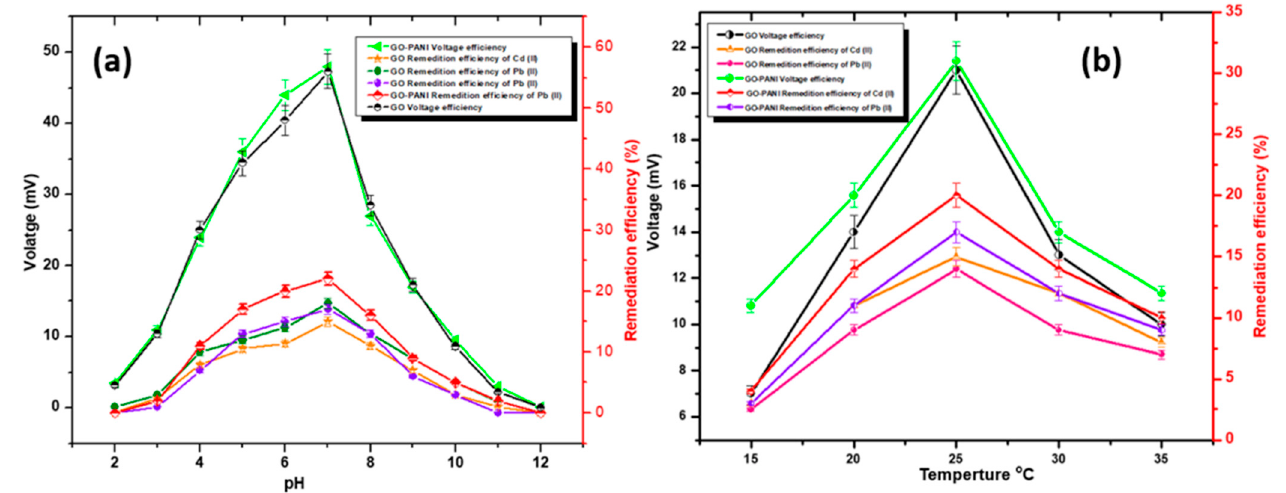
Figure 11. Effect of ( a ) pH and ( b ) temperature by using the self-fabricated anode at different ranges.